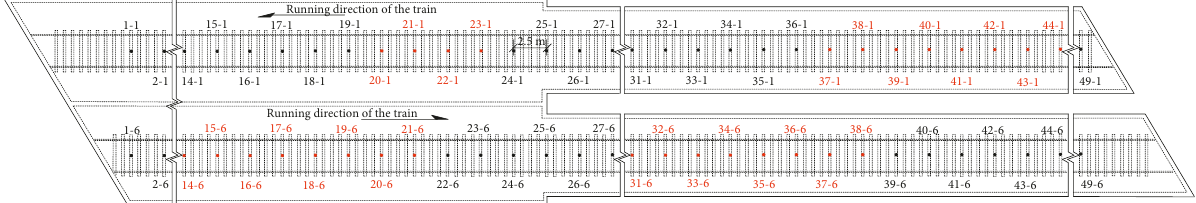
Figure 8: Observation points on the track beds of metro line 3 tunnel.